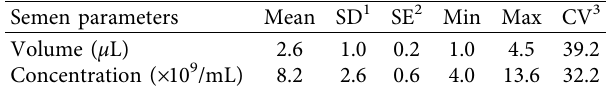
Table 2: Results of analysis of variance: significance ( P ) of the sources of variation affecting sperm viability and CASA parameters in experiment 1.